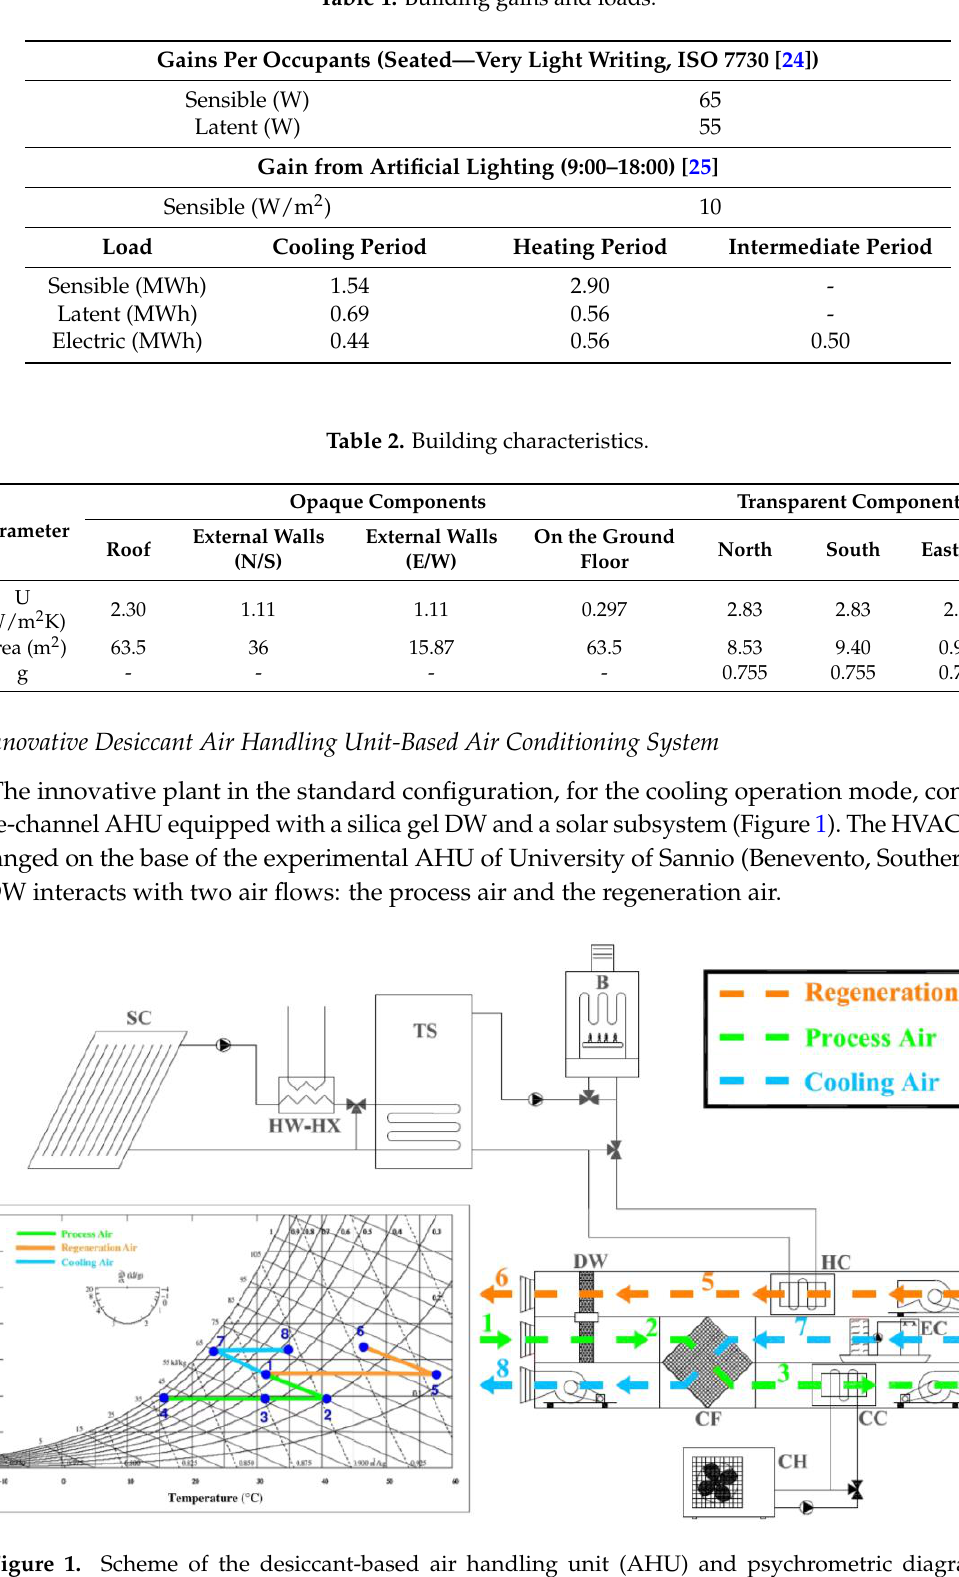
Table 1. Building gains and loads.